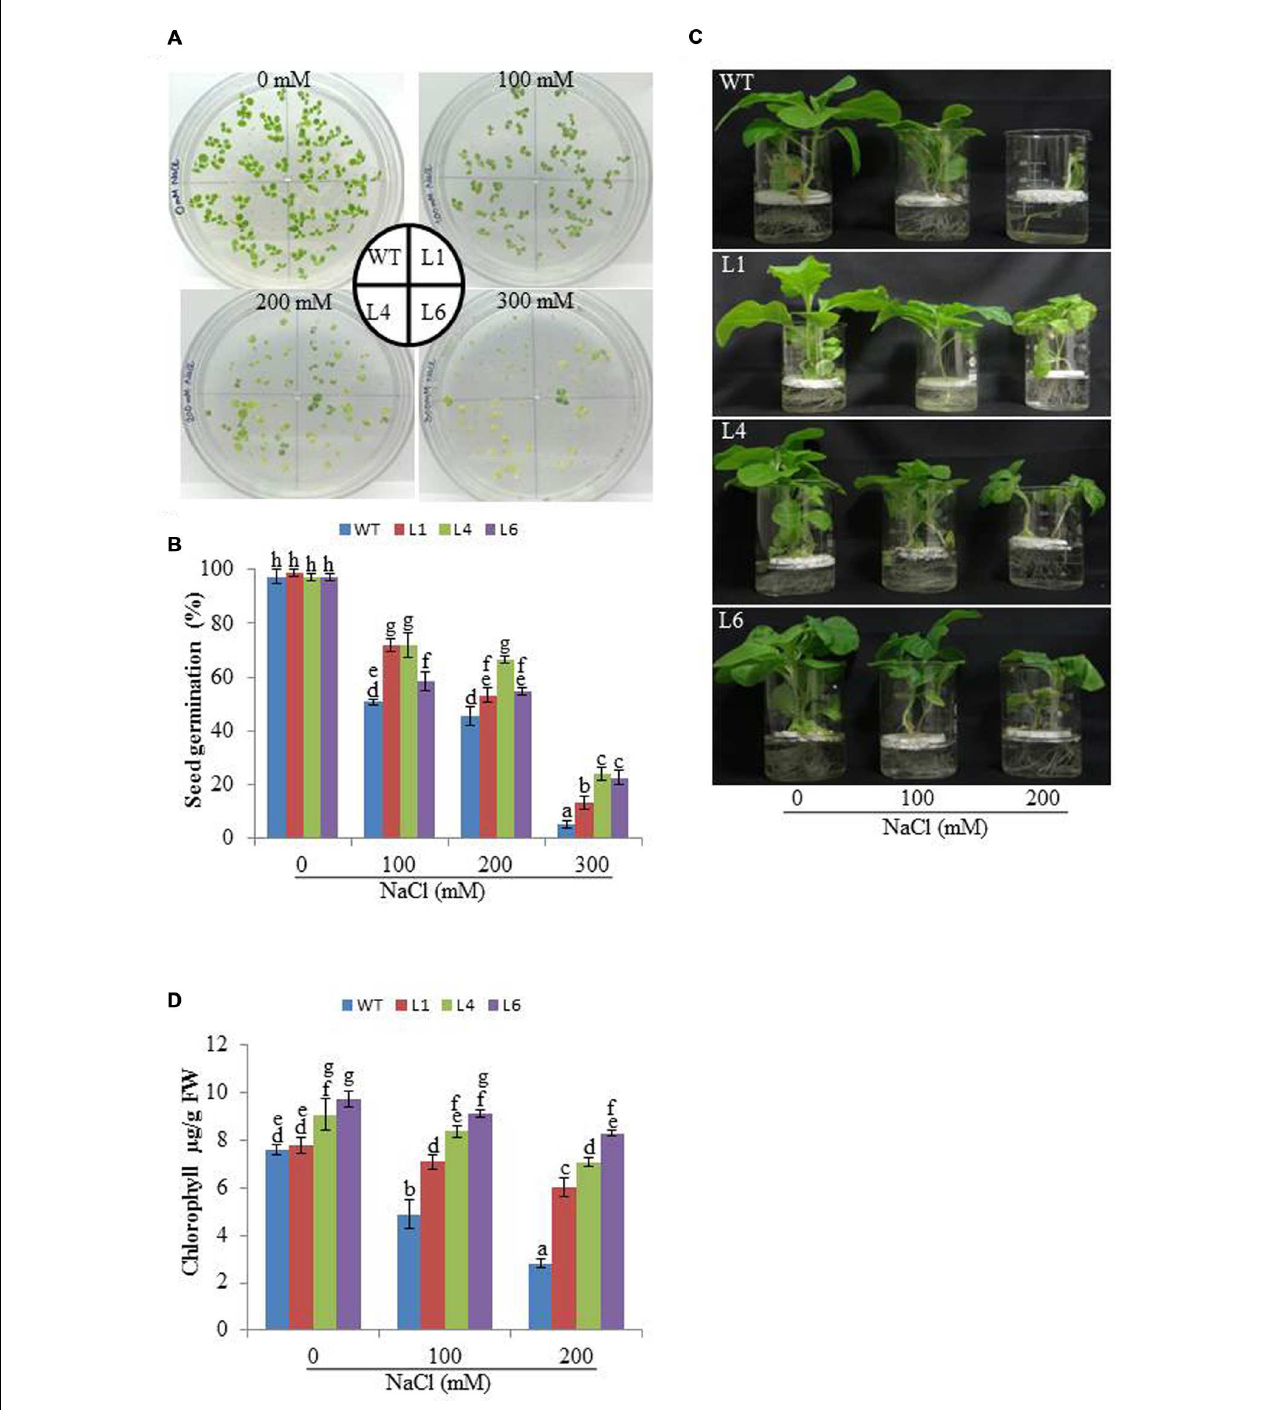
FIGURE 2 | (A) Analysis of seed germination, (B) Percentage seed germination, (C) Morphological analysis and (D) Leaf disk chlorophyll assay of WT and T 1 transgenic lines at different NaCl concentrations.